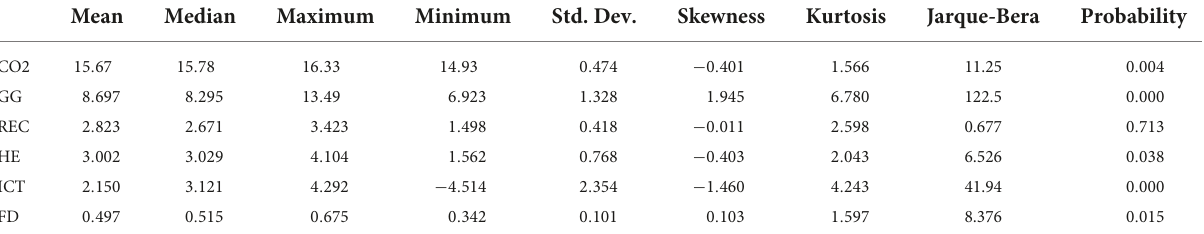
TABLE 2 Descriptive statistics.